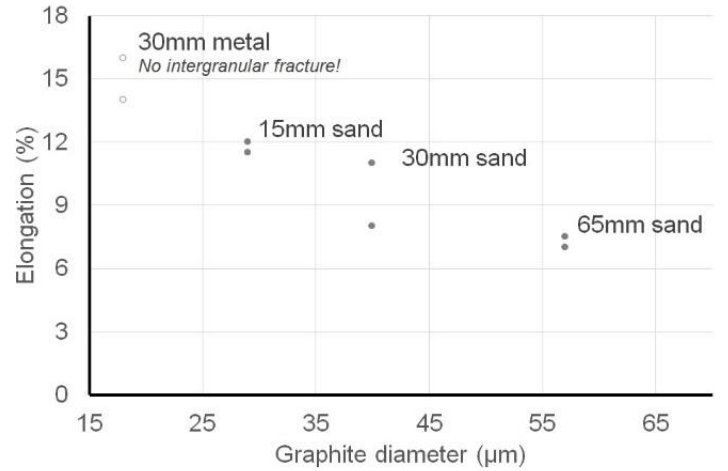
Figure 3. Elongation at 673 K (400 °C) for different thicknesses and molds. Adapted from [29].